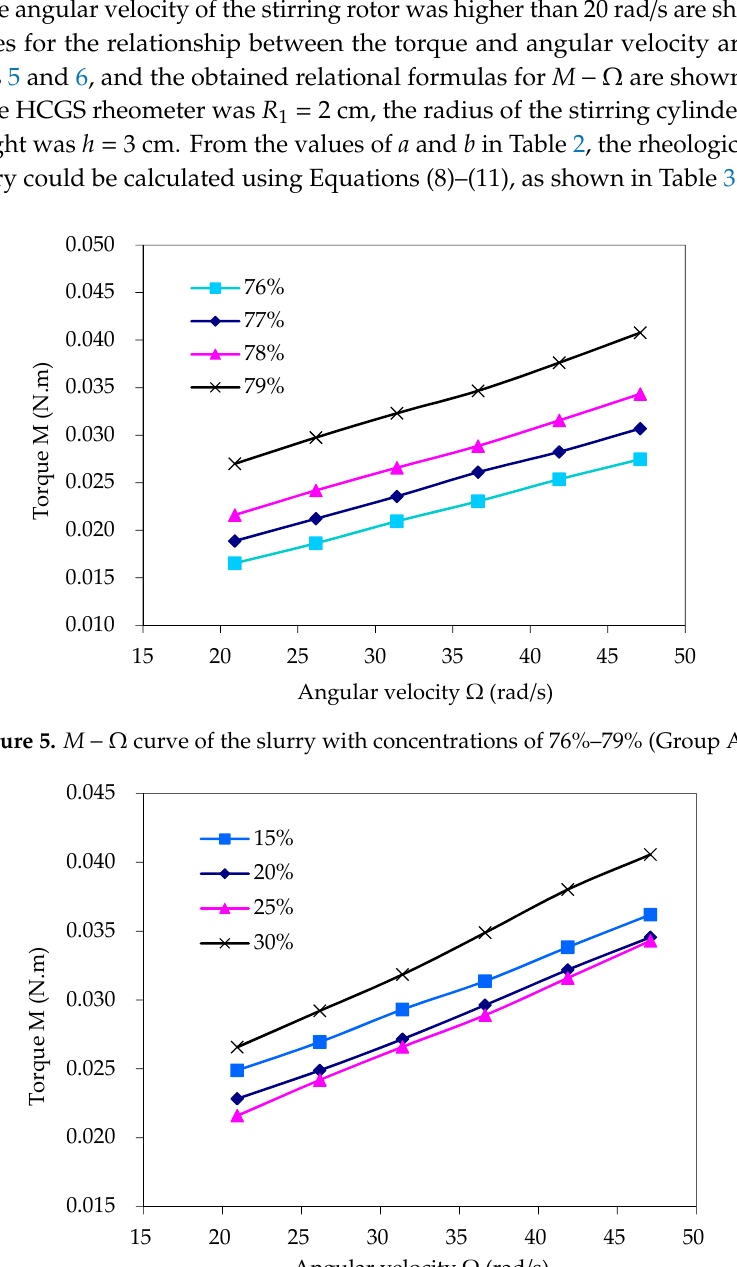
Figure 6. M − Ω curve of slurry with 15%–30% fly ash content (Group Figure 6. (cid:1839) − Ω curve of slurry with 15%–30% fly ash content (Group B). Table 2. (cid:1839) − Ω relationship.